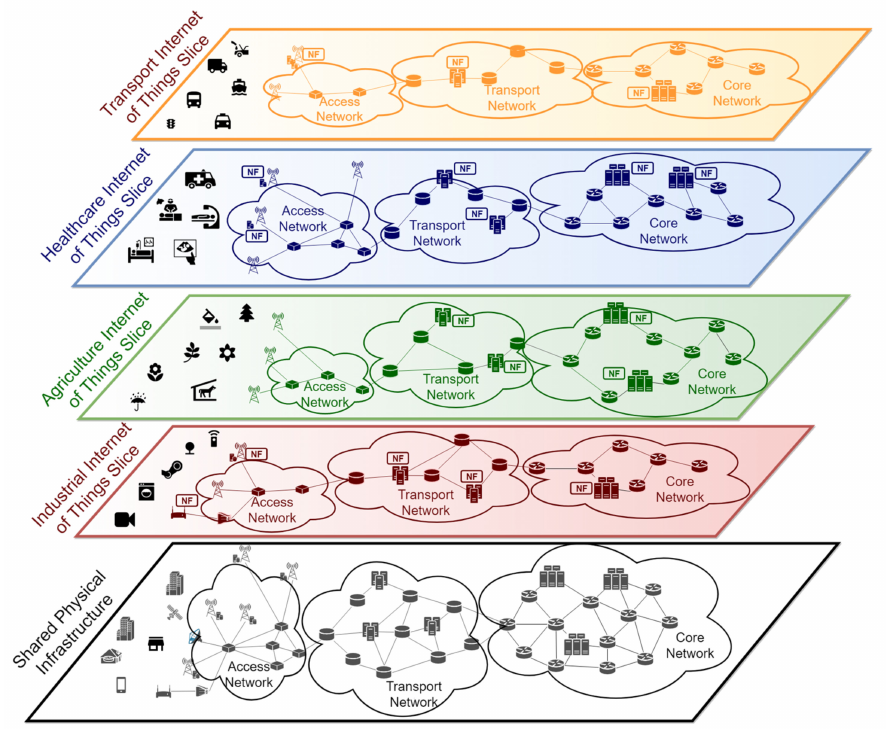
Figure 1. Internet of Things (IoT) network slicing